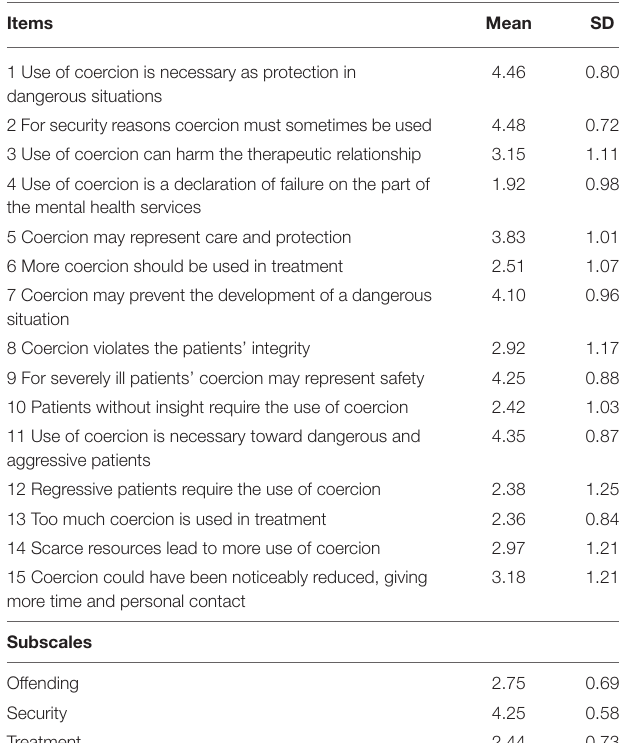
TABLE 1 | Mean and standard deviation for staff attitudes to coercion scale items and subscales ( N =